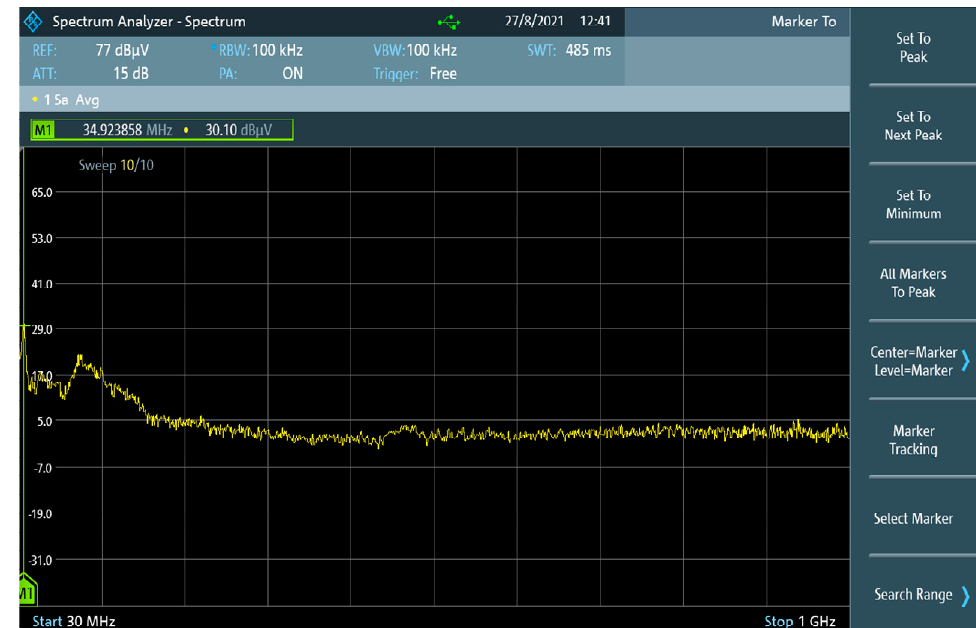
Figure 14. EMI measurement spectrogram of Block B1.